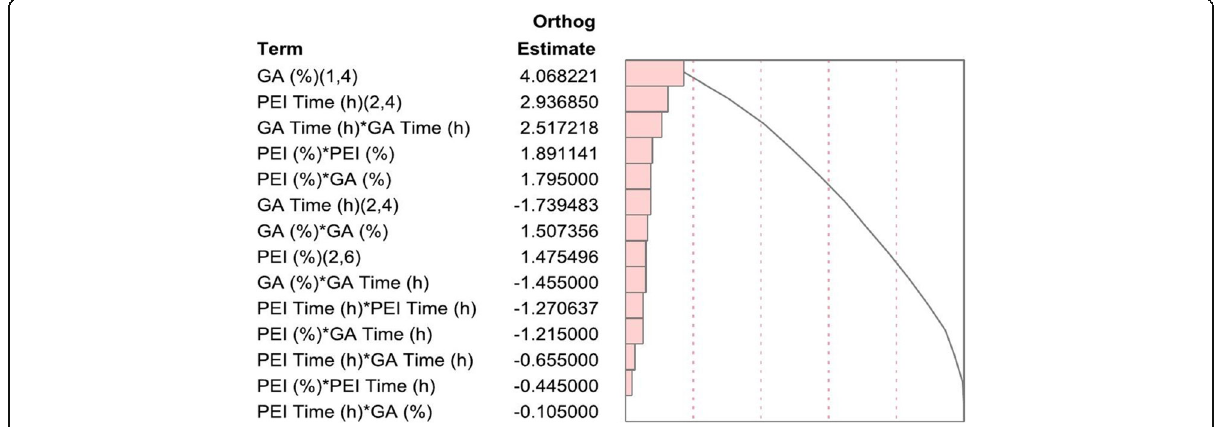
Fig. 4 Pareto chart of CCD for the most significant variables affecting α -amylase immobilization